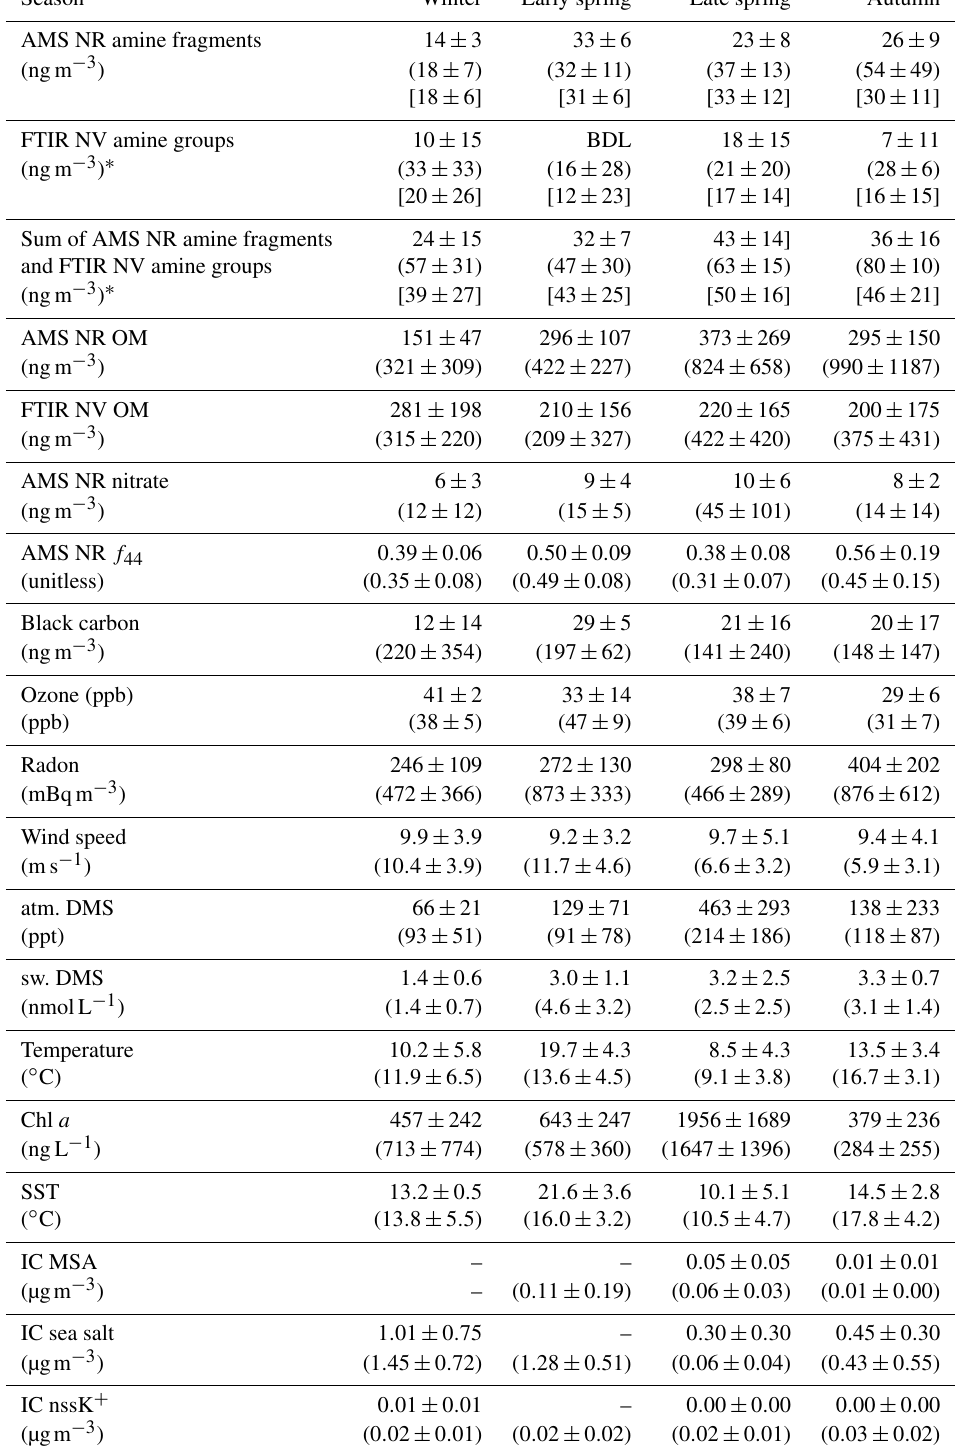
Table 2. Mean concentrations and standard deviations of amine, tracer, and environmental measurements during NAAMES for marine (first line in each row) and continental (second line in each row, in parentheses) periods. Seasonal mean concentrations and standard deviations are given in square brackets and were averaged over the sampling times of filters categorized as marine, continental, or